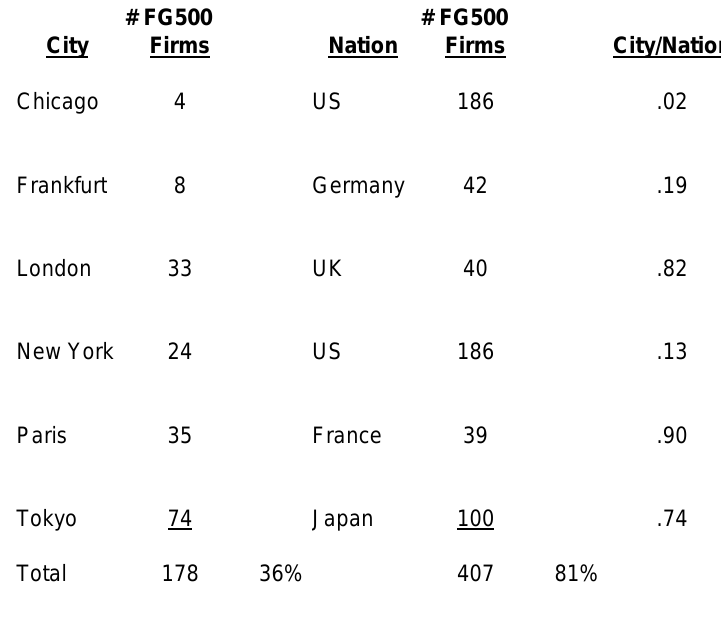
Table 1. Number of FG500 Firms Headquartered in Selected Cities and Countries,